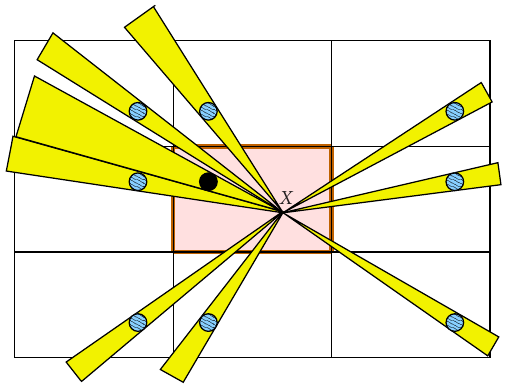
Figure 2: An overview of the proposed model. The “ X ” at the cen- ter of the beams represents the receiver, the solid and dashed cir- cles represent the transmitter and its images, respectively. The high- lighted room is the room of interest. The other surrounding rooms are some of the imaged rooms. The finite-width rays extending from the receiver are visualizations of the e ff ect of introducing clusters.